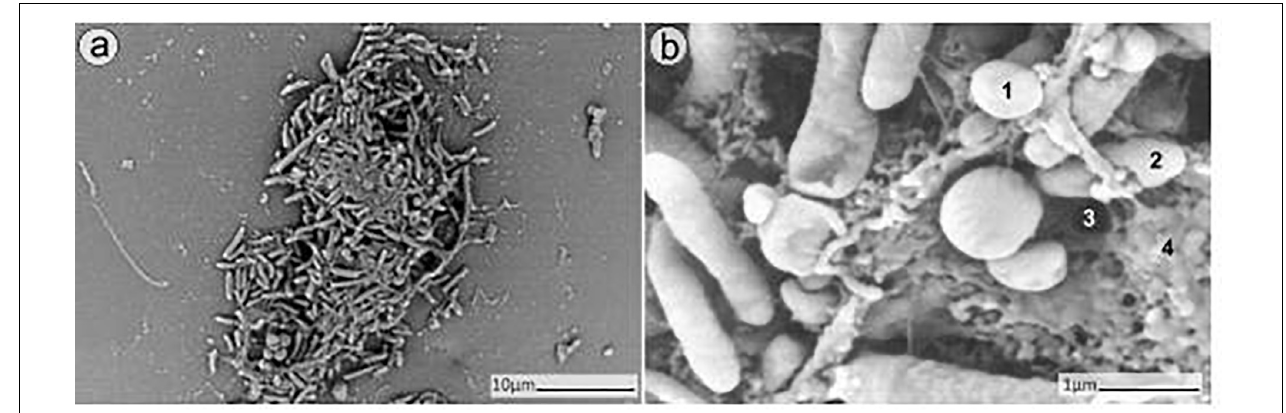
FIGURE 2 | SEM analysis of dual-species biofilm formed by MRSA (ATCC 43300) and P. aeruginosa (ATCC 27853) on porous glass beads after 24h of incubation. Image (b) is a close-up from (a) . Numbers 1 and 2 indicate a MRSA bacterium and a P. aeruginosa bacterium respectively, whereas 3 and 4 point out a water channel and the extracellular polymeric matrix of the biofilm correspondingly.